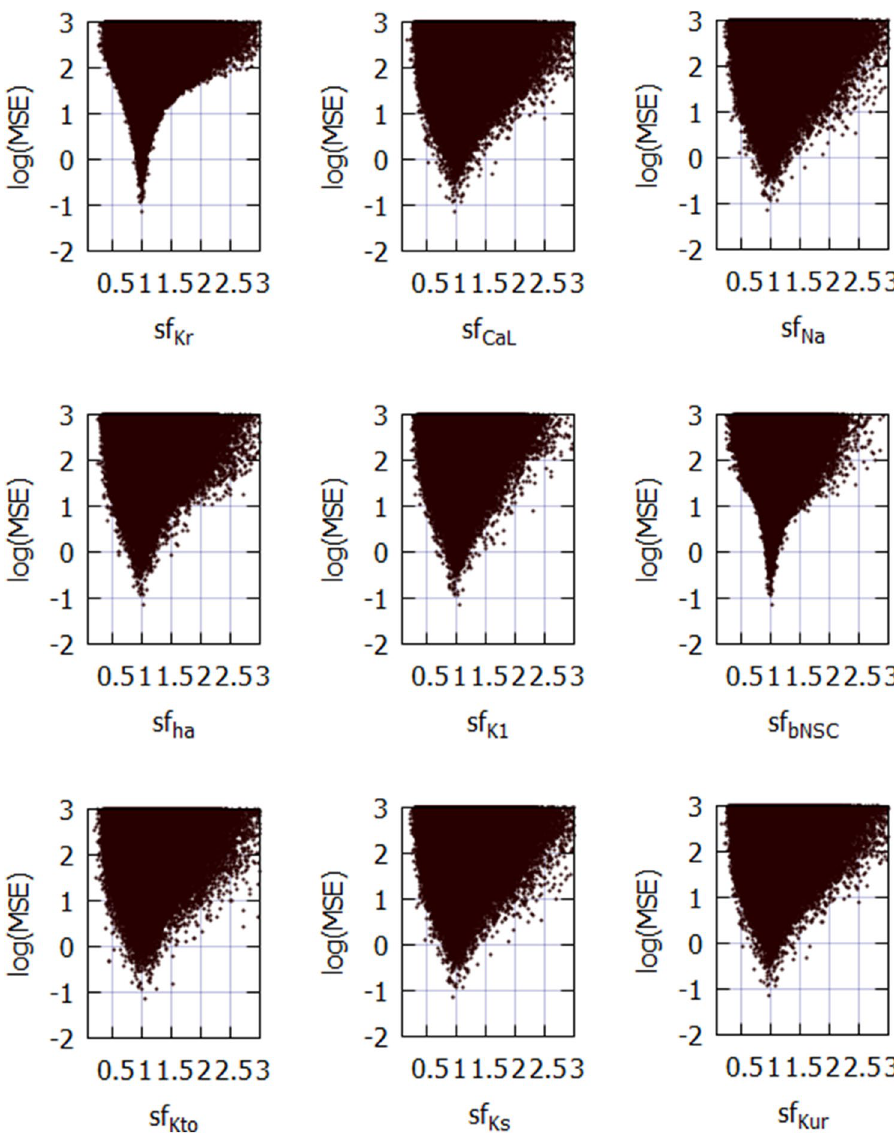
Figure 1. Distribution of MSE calculated between the target and simulated APs modified by randomizing the sf x of nine ionic currents in coordinates of MSE- sf x . All MSE data points were plotted on the logarithmic ordinate against the linear sf x . A total of 5,141,382 points were calculated in cell model No. 86 over the range of 1/10 to approximately 10 times the default sf x . Since the configuration of V m records were largely unrealistic at sf x > 3, MSE points were omitted over sf x > 3.0. To demonstrate the sharp decrease in MSE, the data points were densely populated near the default sf x